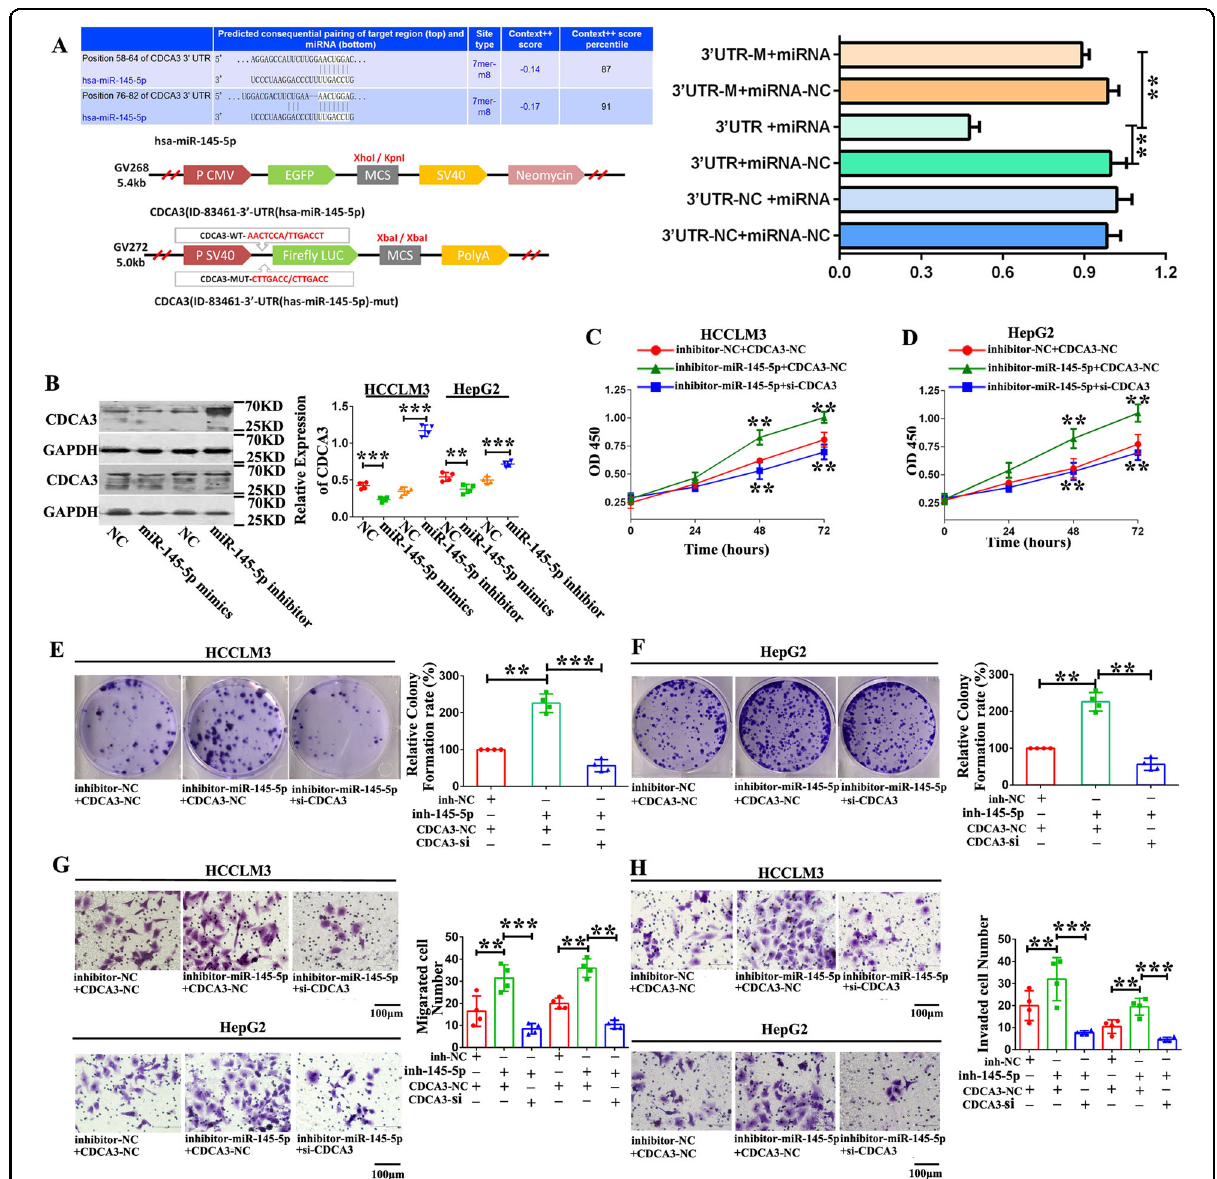
Fig. 7 miR-145-5p targets CDCA3 to sustain HCC cell tumorigenicity. A Schematic of CDCA3 3 ′ UTR wild-type (WT) and mutant (Mut) luciferase reporter vectors. Relative luciferase activities analyzed in 293T cells co-transfected with the miR-145-5p plasmid or miR-NC and luciferase reporter vectors CDCA3 3 ′ UTR (WT) or CDCA3 3 ′ UTR (Mut) (* P <0.05; n = 3). B Western blot analysis indicating that miR-145-5p downregulates CDCA3 (** P <0.01; *** P < 0.001; n = 4). C , D HCCLM3 and HepG2 cell viability following co-transfection with siRNA-CDCA3 and miR-145-5p inhibitor, measured by WST-1 assays (** P <0.01; n = 4). E , F Proliferative capacity of HCCLM3 and HepG2 cells co-transfected with siRNA-CDCA3 and miR-145-5p inhibitor, evaluated by colony formation assay (** P <0.01; *** P <0.001; n = 4). G , H The in fl uence on cell migration and invasion of HCCLM3 and HepG2 cells transfected with